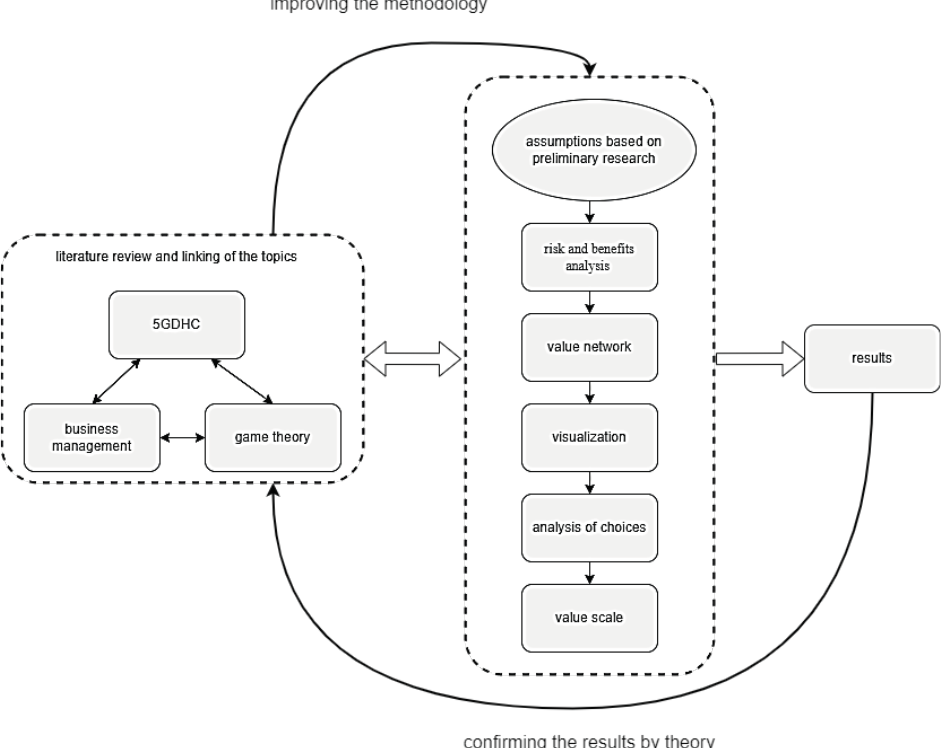
Fig. 1. Workflow of the